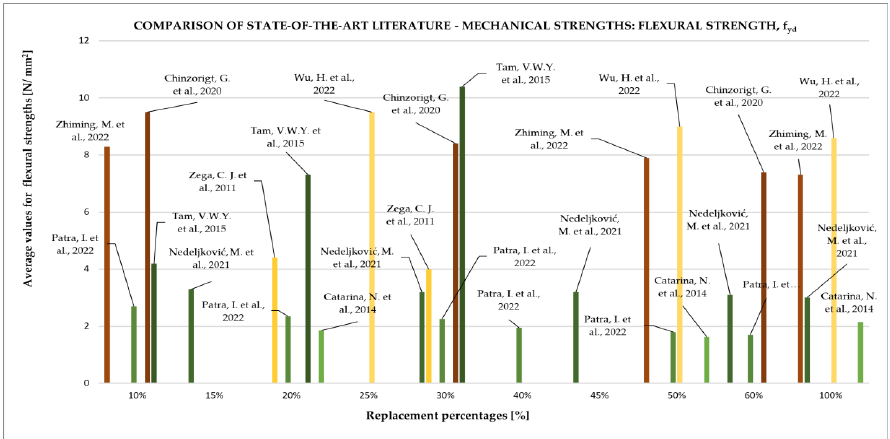
Figure 1. Comparative analysis of bending strengths according to the studies reviewed [3,4,9–